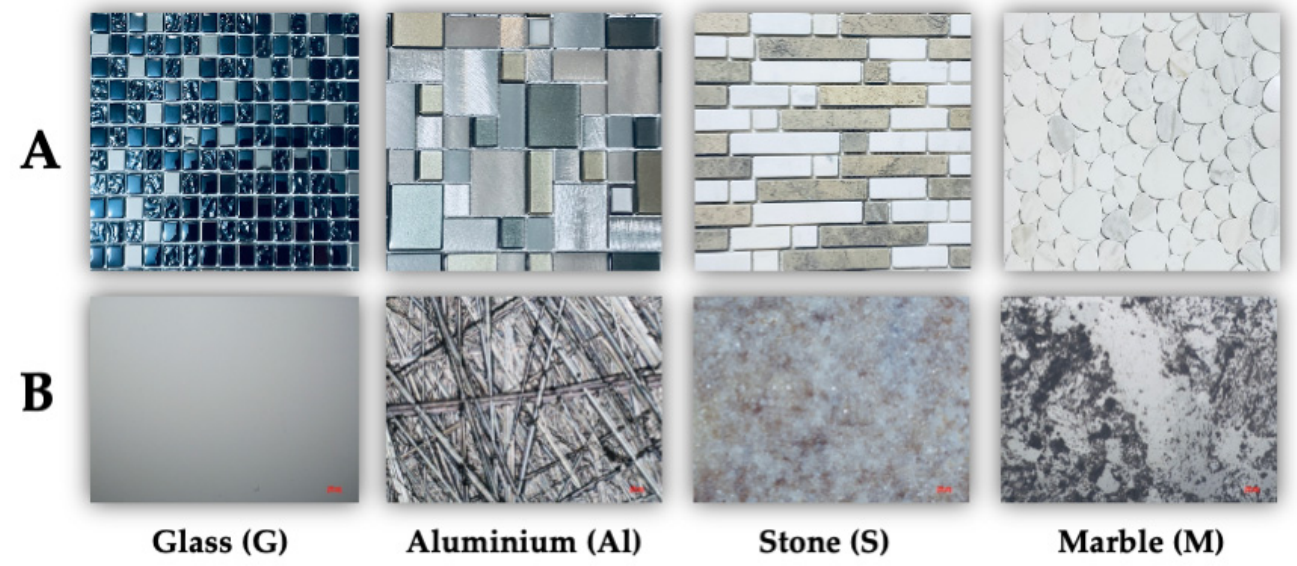
Figure 2. Photographs of the reference sensitive surfaces available on the commercial market ( A ). Images of the reference sensitive surfaces at 40× magnification ( B ).